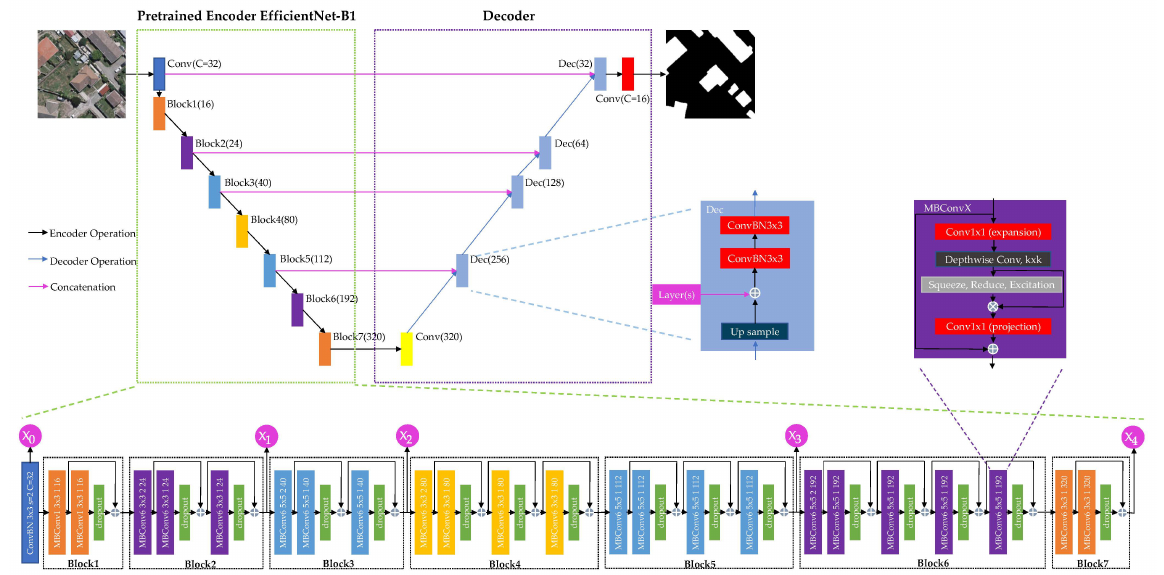
Figure 3. The top shows the UNet architecture, which consists of an encoder (green dotted box), a decoder (purple dotted box) and skip connections (pink). The bottom panel shows the details of the EfficientNet-b1 module, which includes seven blocks. The right side presents the submodule of the decoder and the MBConv module of the encoder